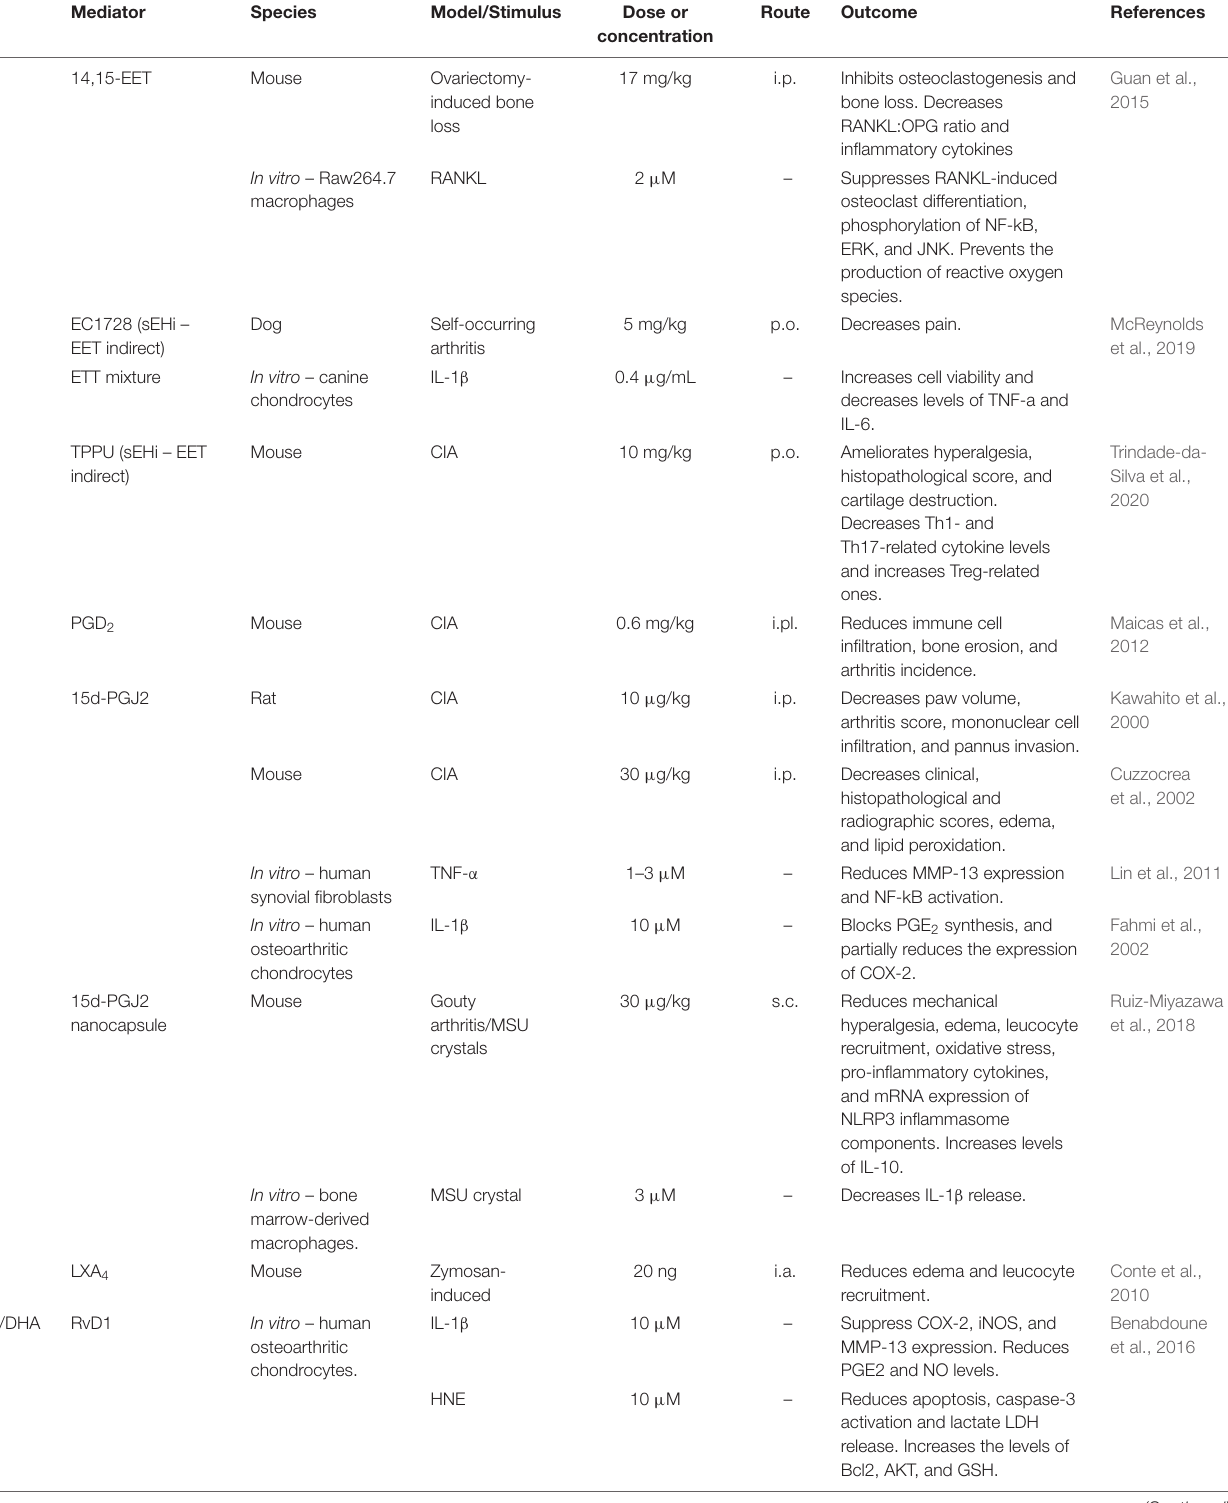
TABLE 4 | Pre-clinical effects of SPMs in rheumatic